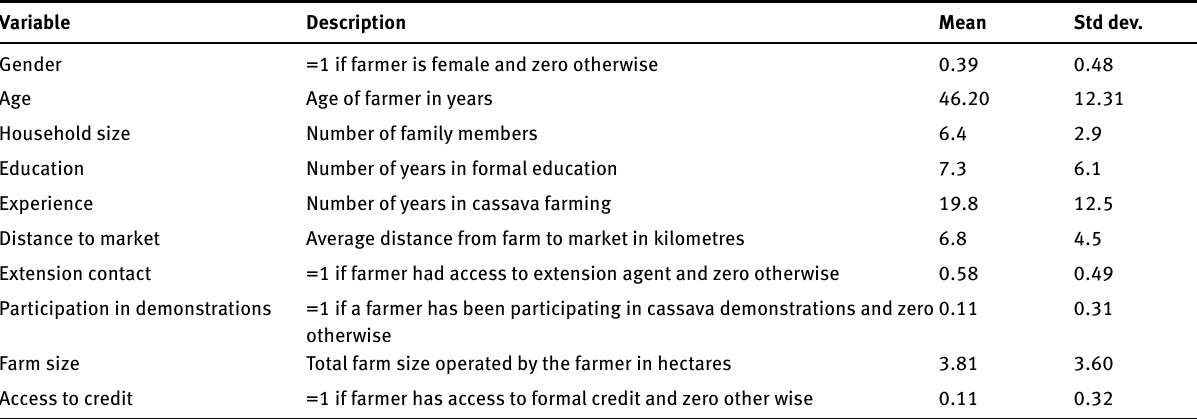
Table 3: Descriptive statistics of respondents